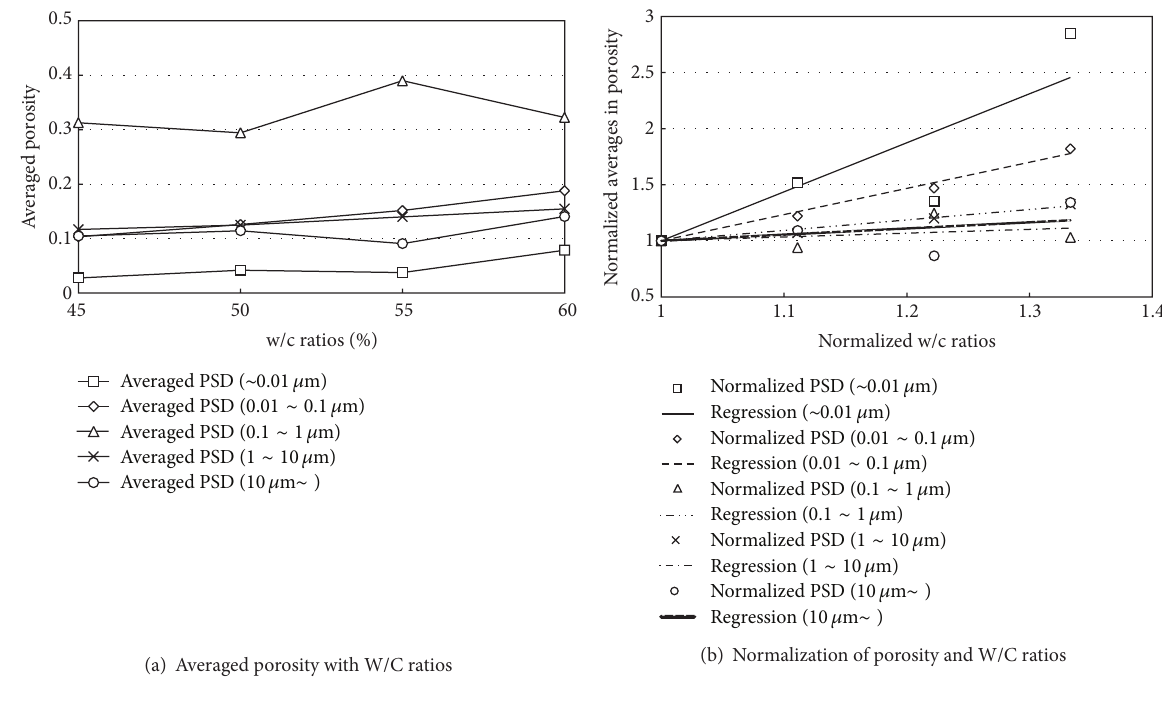
Figure 10: Changes in averaged and normalized porosity with W/C ratios.